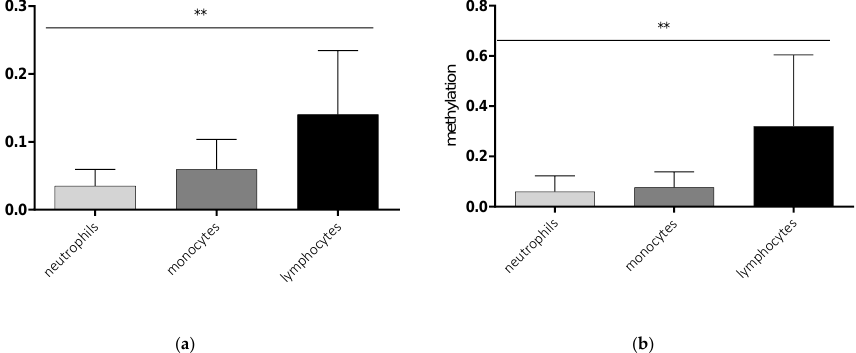
Figure 1. AQP5 promoter methylation in the promoter region nt-145 to nt-49 in different blood cells of healthy controls ( a ) and septic patients ( b ). Neutrophils, monocytes, and lymphocytes were isolated using magnetic separation, DNA extraction, bisulfite conversion and methylation-specific PCR for the promoter region from nt-49 to nt-145. AQP5 promoter methylation was significantly different between the immune cells analyzed in healthy controls (( a ) p = 0.0039, n = 10) and septic patients (( b ) p = 0.0041, n = 10), (** p ≤